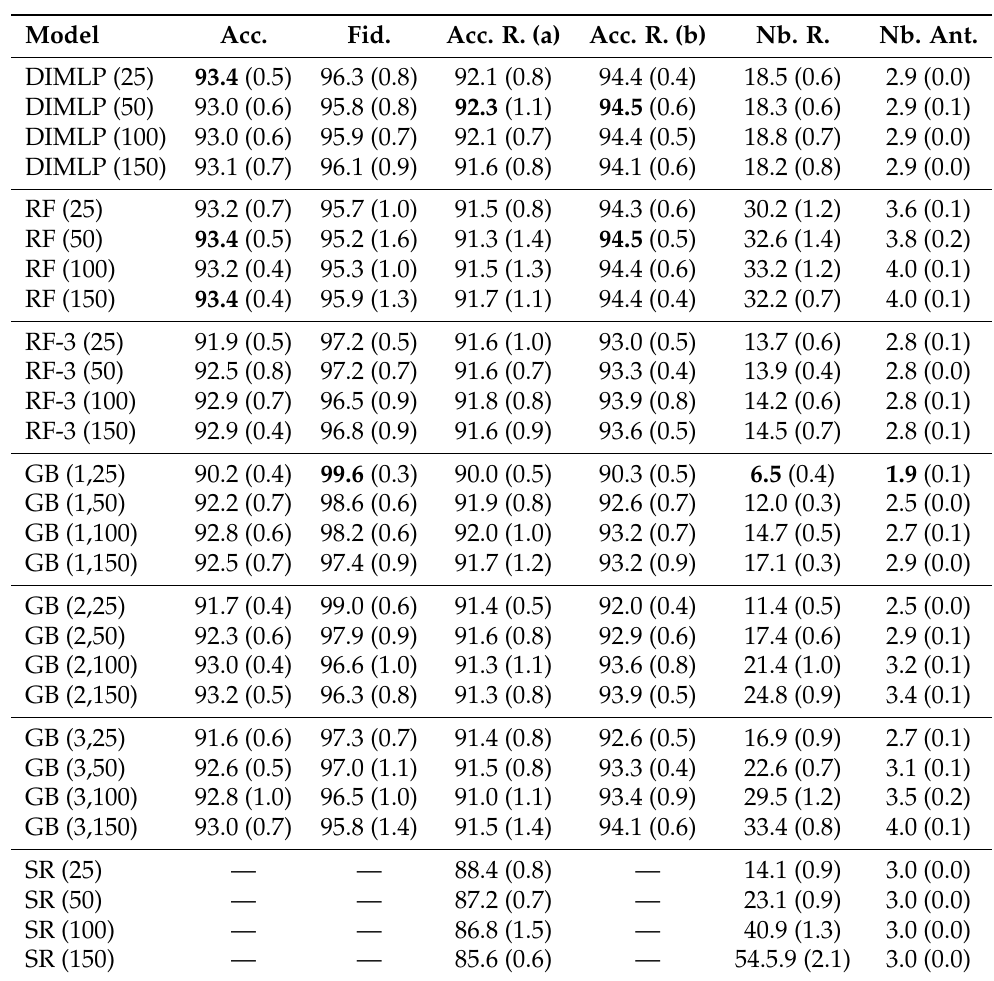
Table 6. Average results obtained on the “Ionosphere” dataset. For each column, the highest average accuracy or average fidelity is represented in bold, along with the lowest average number of rules or average number of